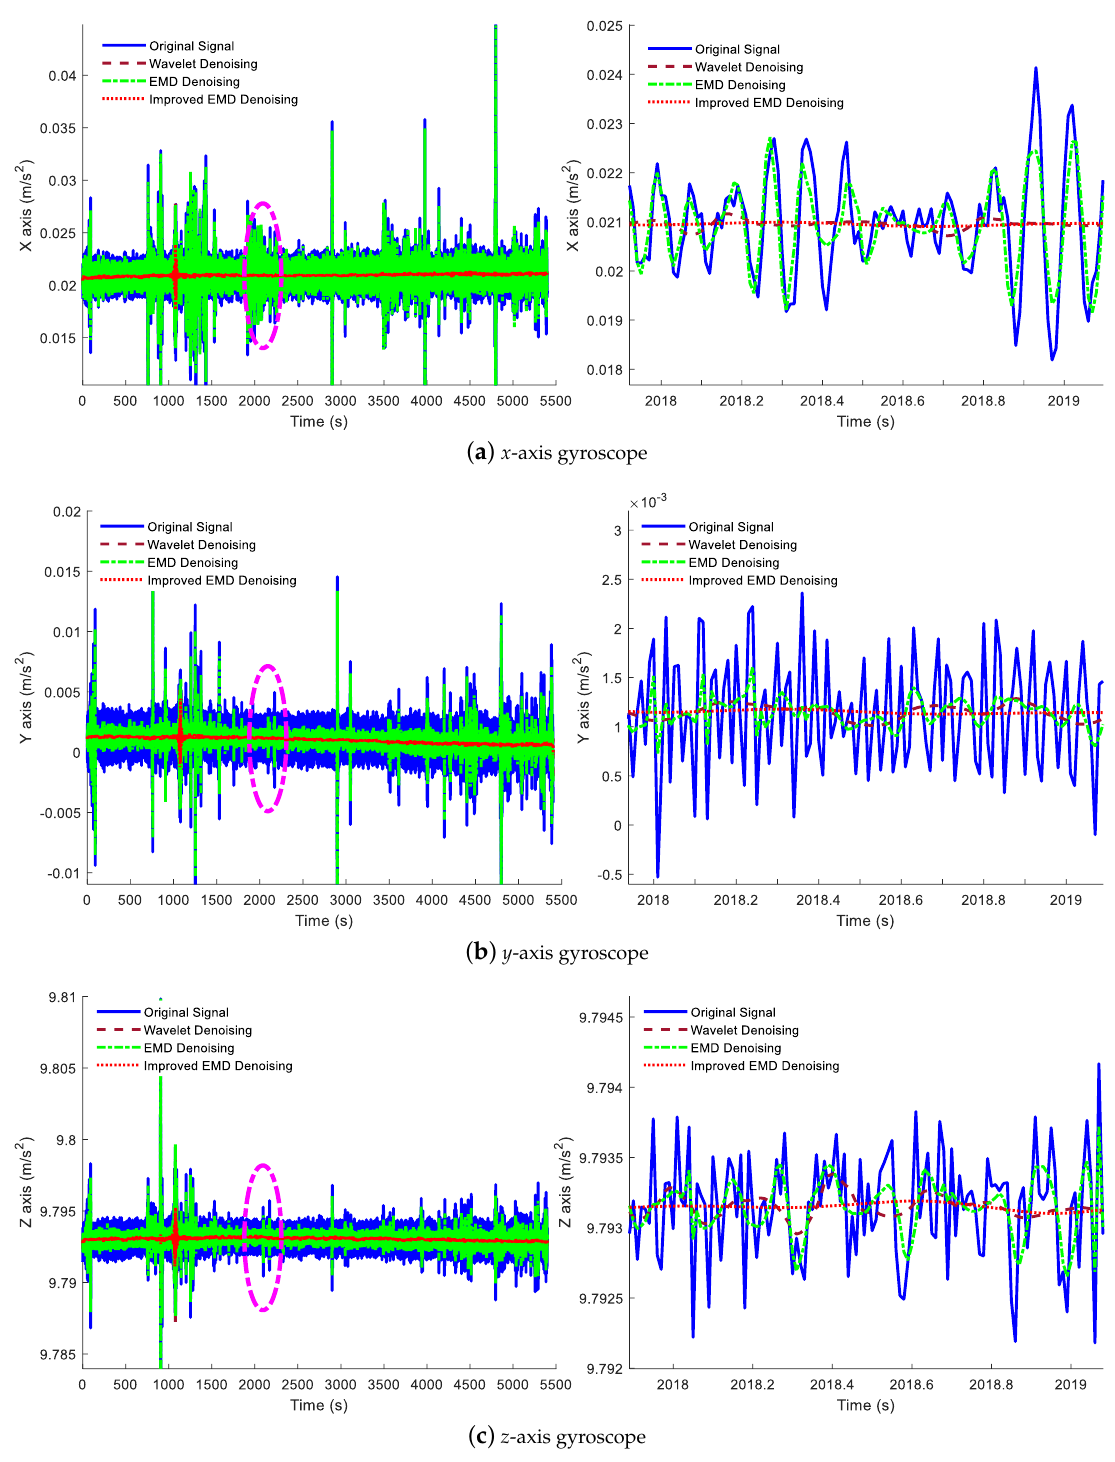
Figure 6. Accelerometers’ denoising result by utilizing multiple denoising methods. The left subfigures are the denoising results of the x -axis, y -axis and z -axis accelerometers and the right subfigures are the local magnifications of the purple elliptical